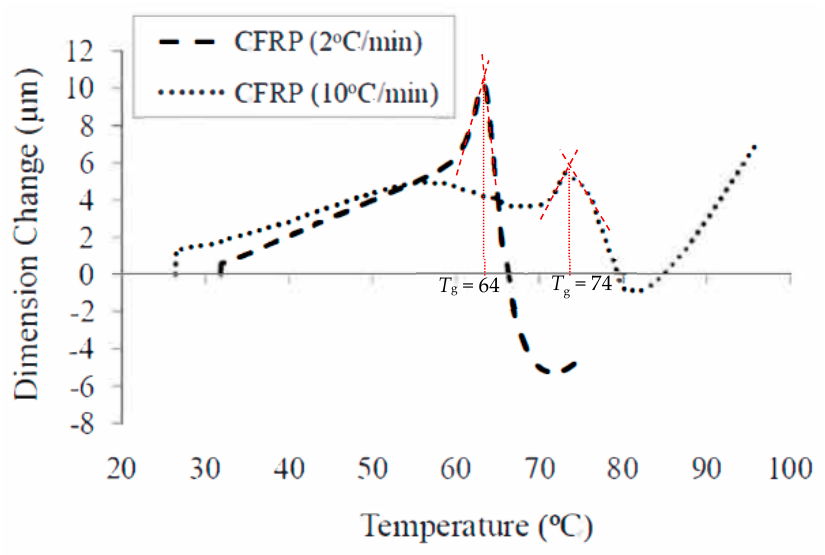
Figure 10. Variation of T g in CFRP composites as a function of temperature and heating rate.